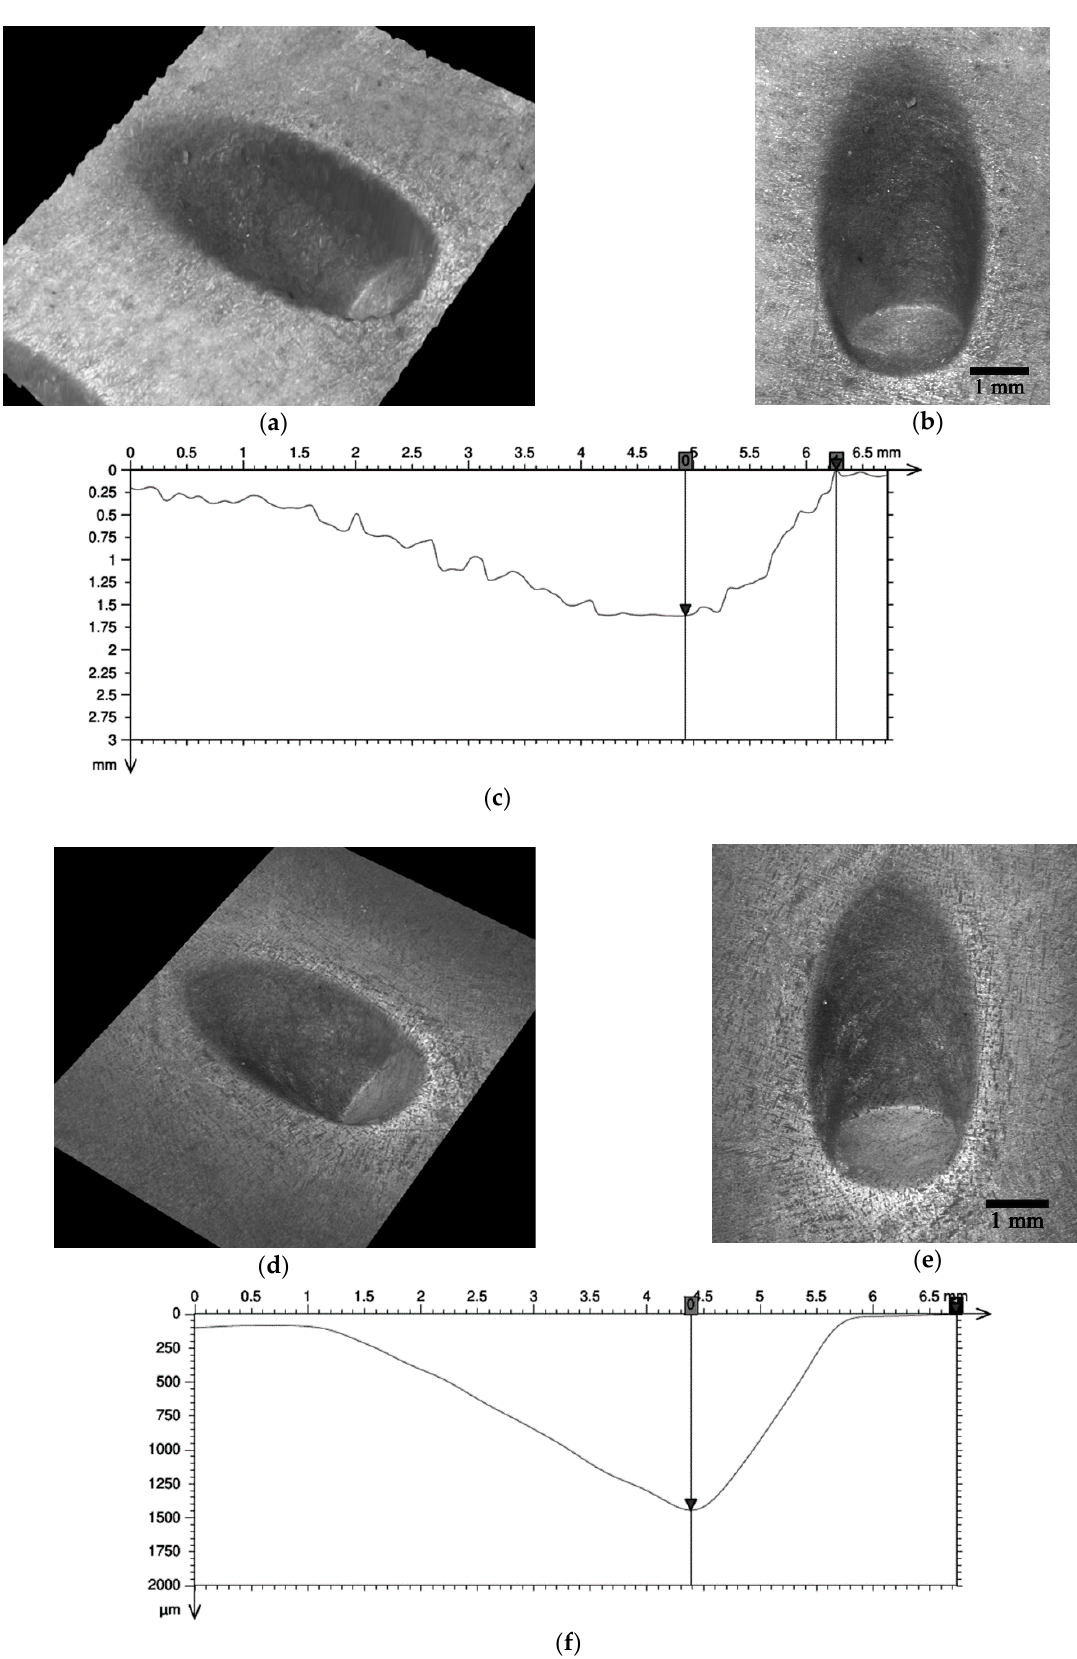
Figure 4. Morphology of the signs of erosive wear. ( a – c ) corresponding to experiment 1; ( d – f ) corresponding to experiment 7.